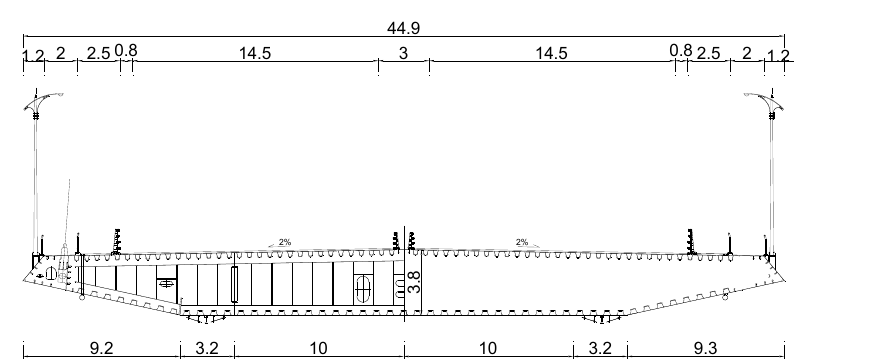
Figure 1. Elevation of the bridge (unit, m).